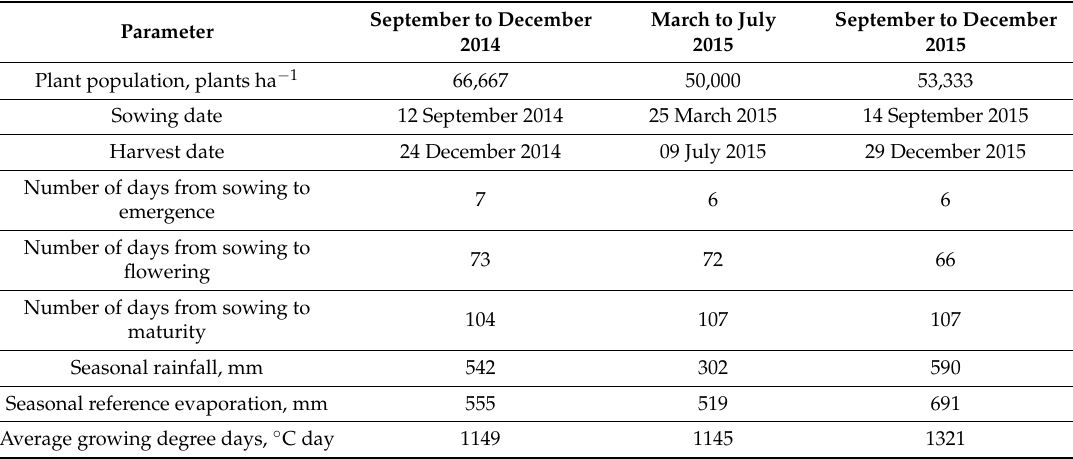
Table 1. Experimental and agronomic data.